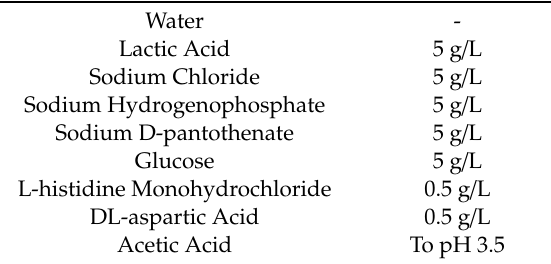
Table 1. Synthetic sweat